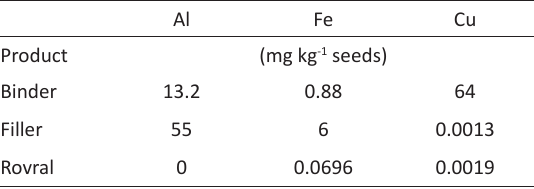
Table 3. Amount of Al, Fe and Cu in binder, filler and Rovral applied to 1 kg of seeds, n=1